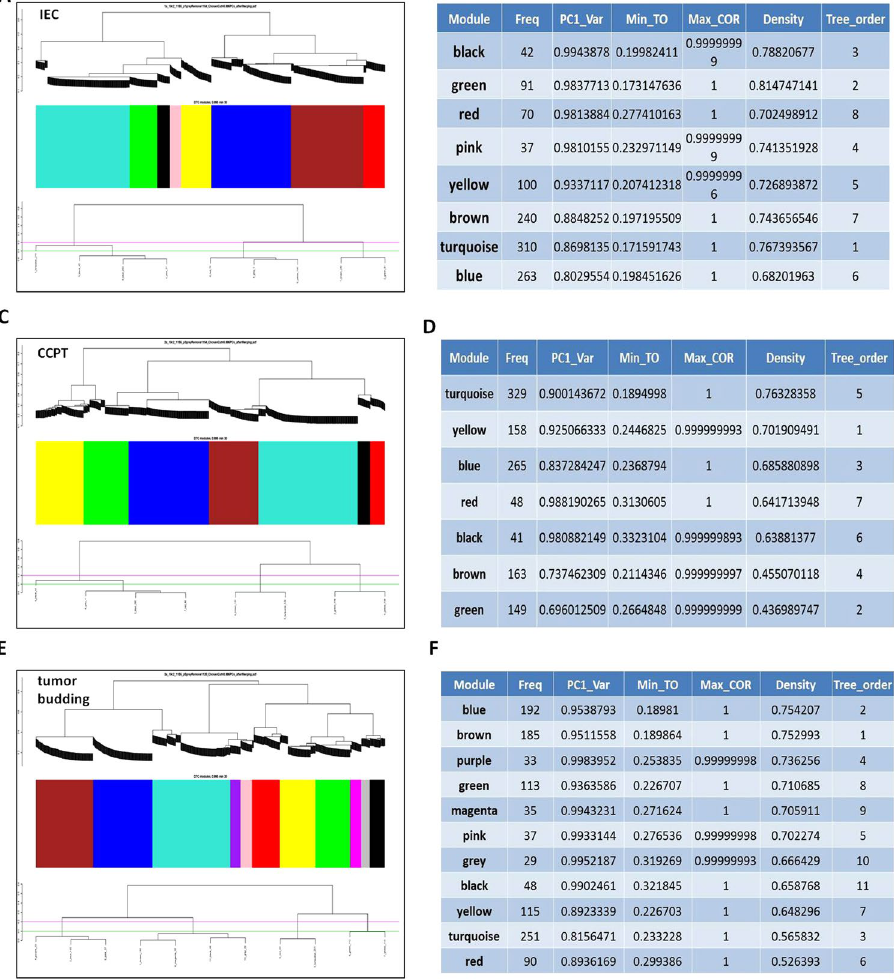
Figure 4. Gene module construction of IEC, CCPT, and tumor buds. ( A , C and E ) The gene module construction was based on topological overlap. The gene modules are shown in different colors. Each color stands for a gene module in which the genes in the model had the same expression trend and thus might perform the same function at the protein level. ( B , D and F ) The biological characteristics of the gene module: Freq represents the number of genes enriched in the gene module; PC1_Var represents the variation range of gene module. The larger the variation value, the greater the specificity of the gene module; Density represents the stability of the gene module. The greater the density value, the more conservative of the gene module; Min_ To indicates the minimum topological overlap value between genes in the module, which means the minimum correlation coefficient among genes enriched in the gene module, and Max_COR indicates the maximum topological overlap value between genes in the module. The larger the topological overlap value, the greater the correlation among genes in the module. Tree_order represents the ID of the gene